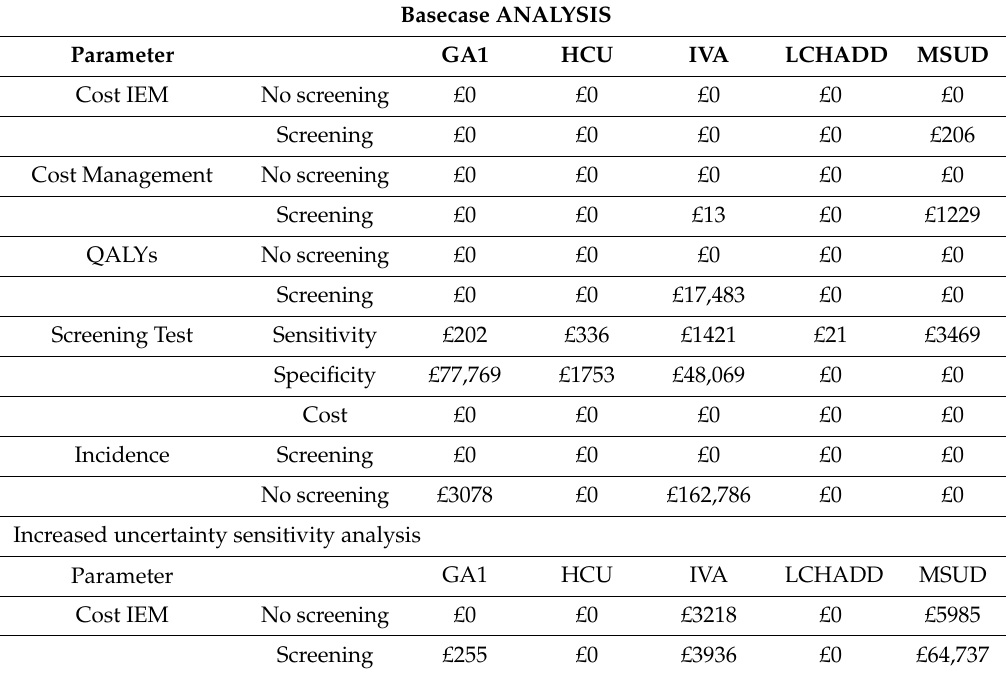
Table 4. Expected value of perfect information